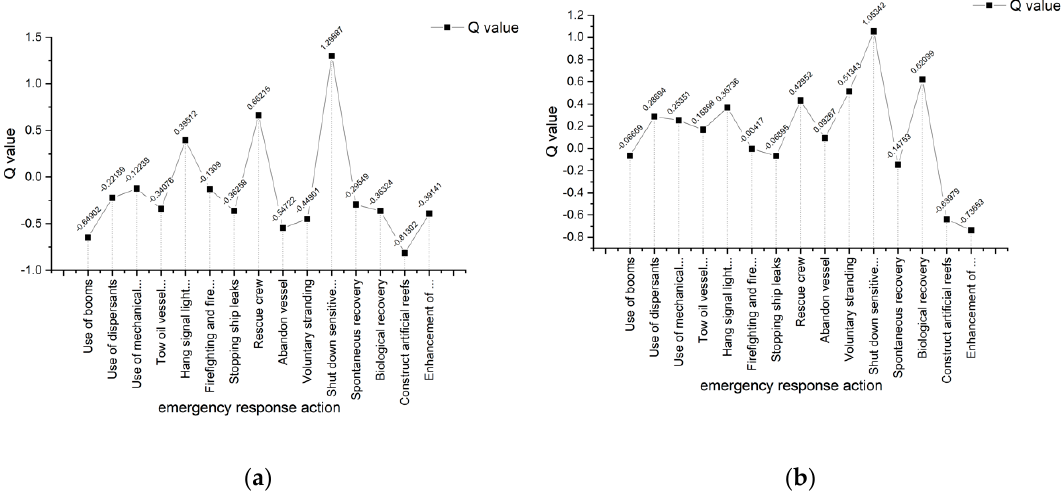
Figure 5. Results of the retrained model with the new reward function. ( a ) Q value of the emergency response action for oil spill scenario instance form the case “BRAER” ( b ) Q value of the emergency response action for oil spill scenario instance from the case “TANIO”.